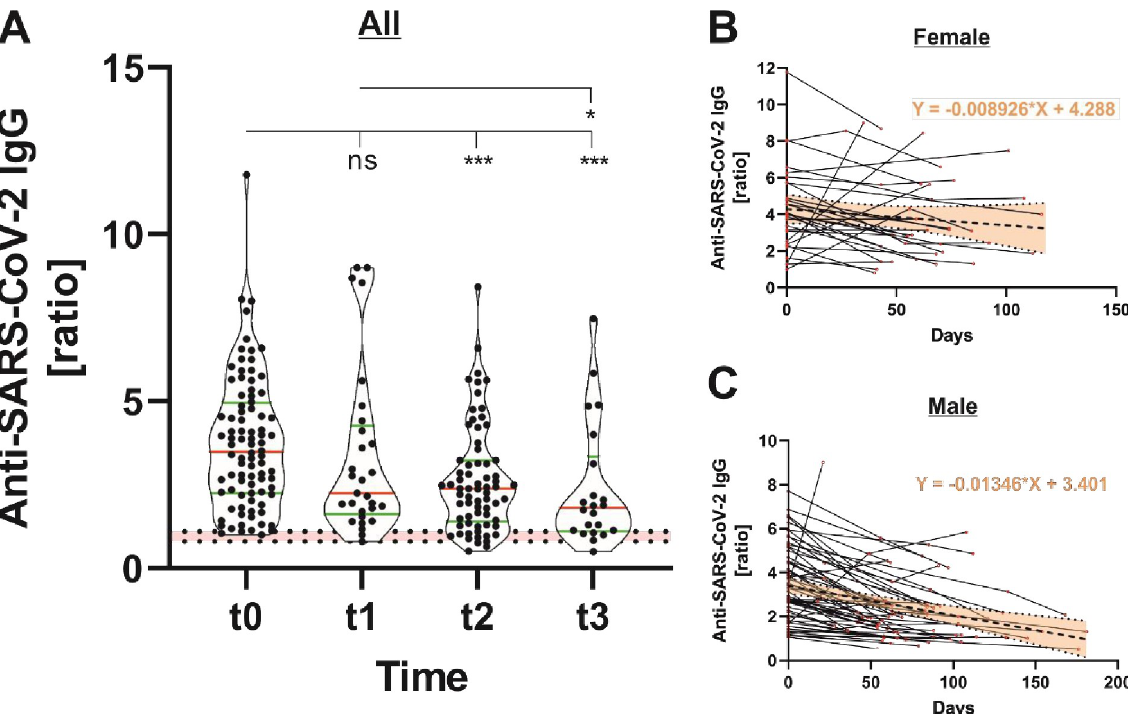
Fig 3. Persistence of anti-SARS-CoV-2 IgG-binding antibodies directed against the viral spike protein (n = 88). Anti-SARS-CoV-2 IgG ratios were determined at different time points (t0 = initial seropositivity, t1 = up to 50 days after initial seropositivity, t2 = 50–100 days after initial seropositivity, and t3 = 100–200 days after initial seropositivity) using a semiquantitative assay from Euroimmun (A). Considering regression line slopes, IgG-binding antibodies were more persistent in female (B) compared to male (C) blood